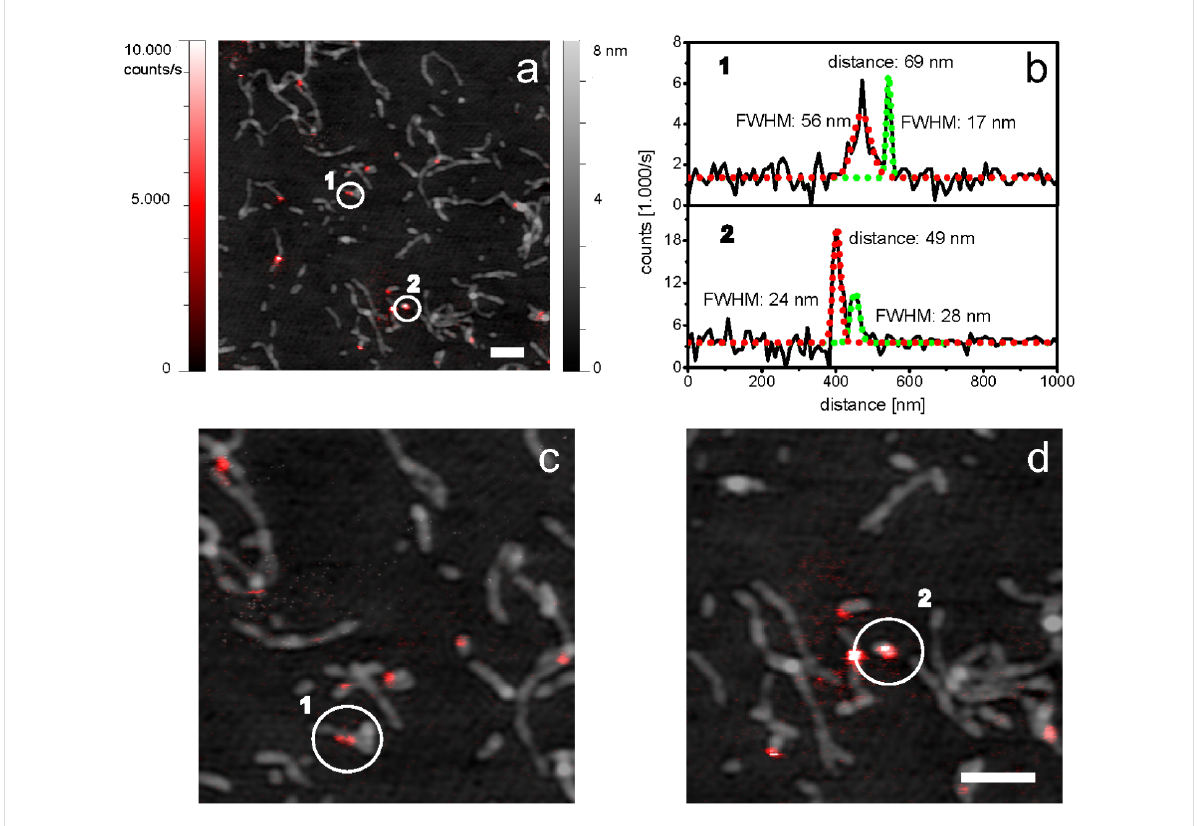
Figure 4: aSnom data of fluorescently labeled desmin filaments. a) Combined fluorescence and topography dataset of wild type desmin. b) Fluores- cence intensity cross sections of two adjacent fluorophores are extracted to estimate the optical resolution. The peaks are approximated by a Gaussian distribution to determine the FWHM. c,d) The marked areas are magnified for better visibility. All scale bars indicate 500 nm.